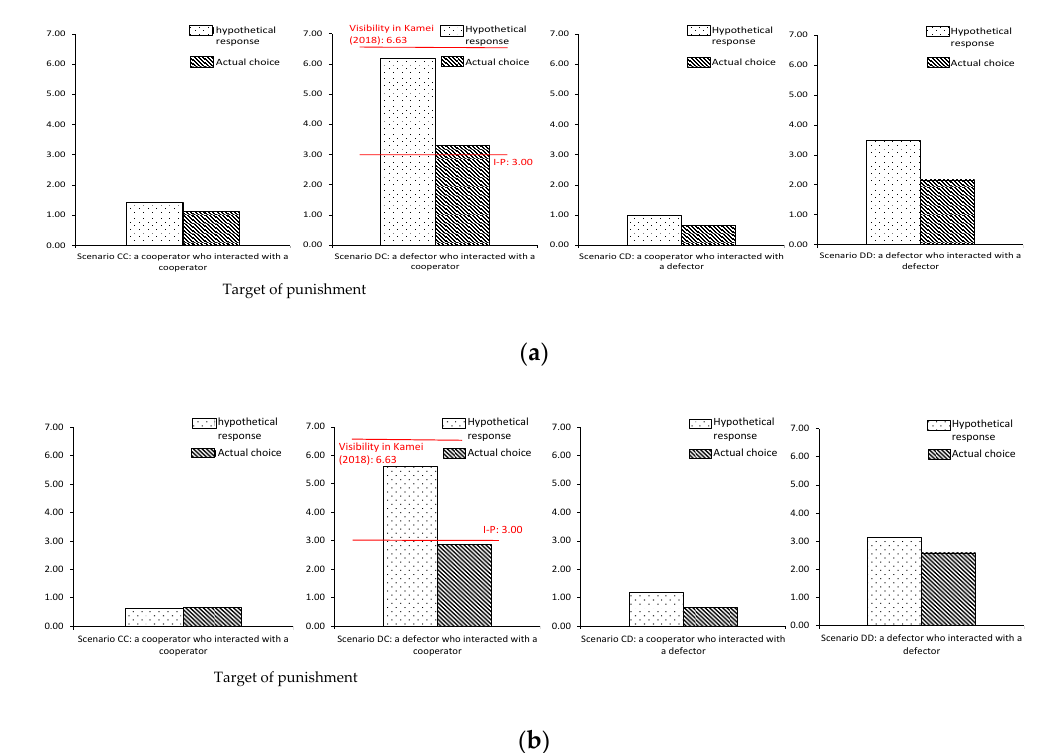
Figure 2. Pairs’ Pre-communication Willingness to Punish versus After-Communication Willingness to Punish: ( a ) The J-P treatment; ( b ) The J-P-C treatment. The vertical axes indicate average punishment points per PD player. Each figure shows pre-communication and after-communication punishment points. See supplementary material Table S5 for comparisons between the hypothetical responses and actual punishment in each scenario.